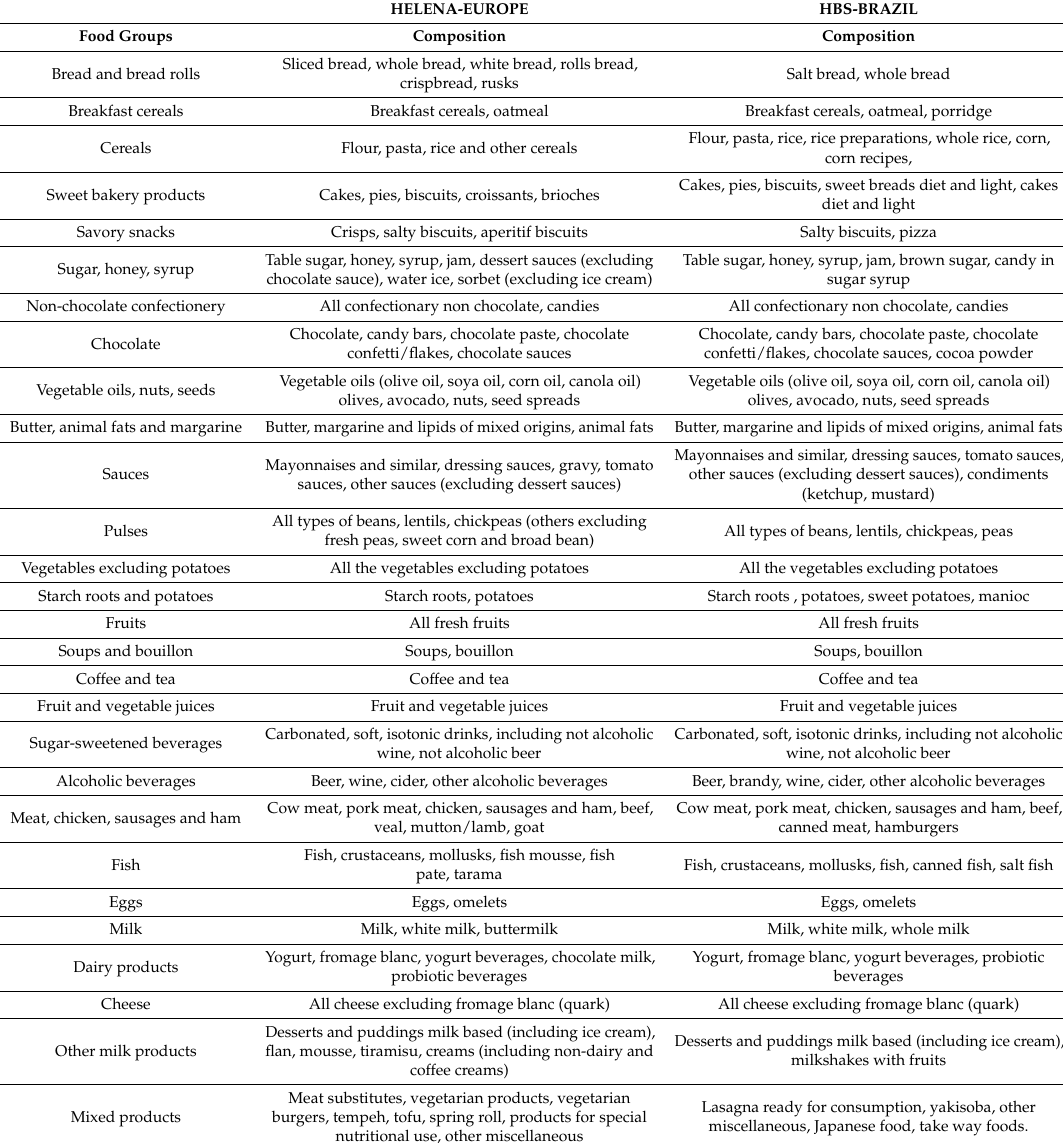
Table A1. Description of the foods that composed each of the 28 food groups included in the factor analysis (HELENA-Europe 2006/2007 and HBS-Brazil 2008/2009).